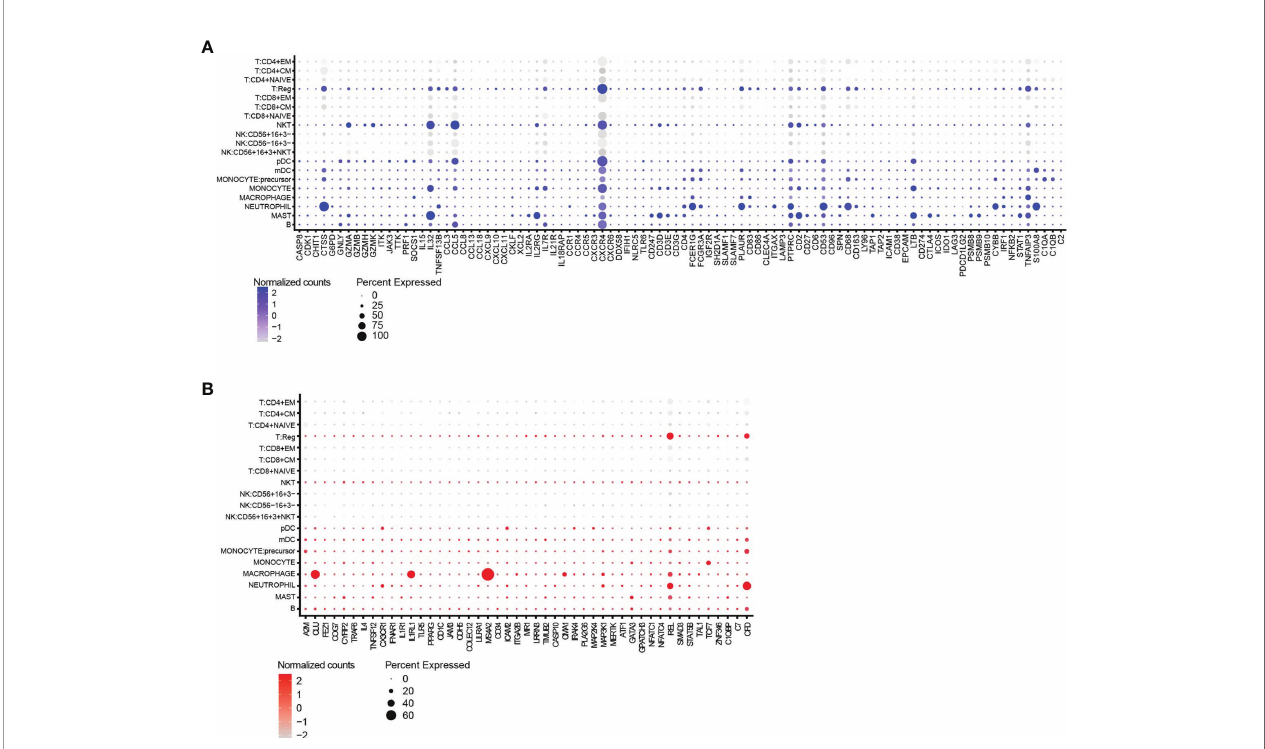
FIGURE 6 | Gene expression provides insight into the cell types associated with a high TIL-score. (A) The split dot blot shows immune cell types ( y -axis) and genes ( x -axis) that are directly correlated with the TIL scores. Genes that are not expressed in any cell population are not plotted. (B) The split dot blot shows immune cell types ( y -axis) and genes ( x -axis) that are inversely correlated with the TIL scores. Genes that are not expressed in any cell population are not plotted. Data information: the size of the circle represents the percentage of cells showing expression, while the color code represents the normalized counts of every